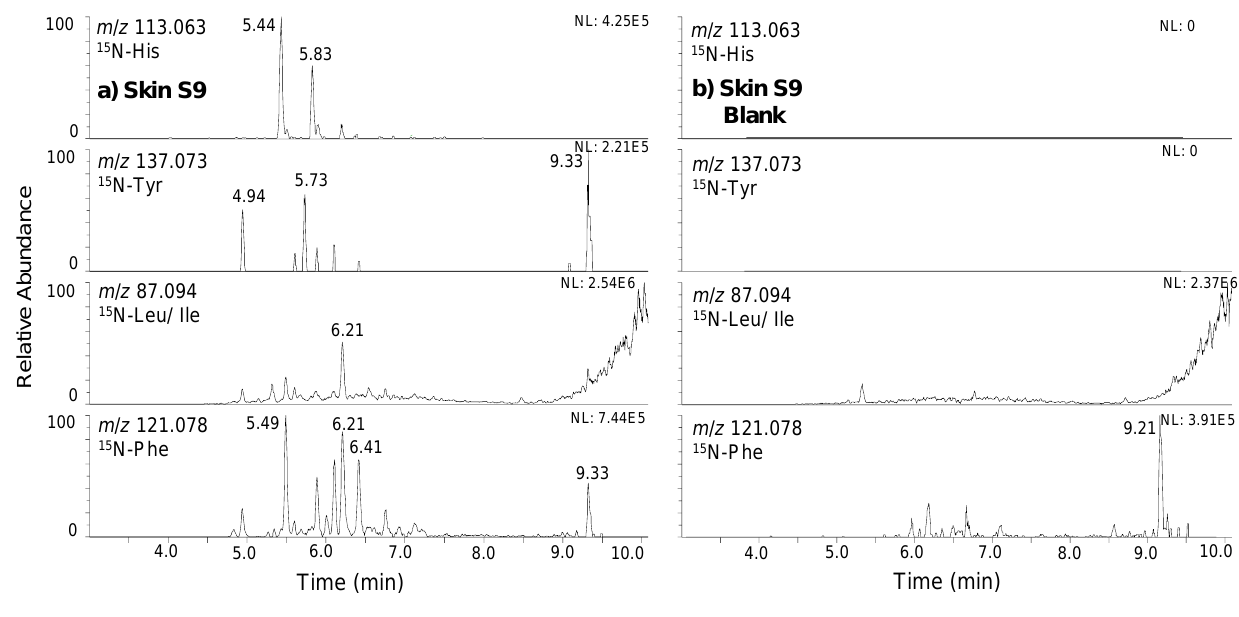
Figure 3. AIF chromatogram of the extracted ion traces corresponding to the most abundant 15 N- labelled immonium ions, showing the metabolites obtained after incubation of 15 N-hGH in skin S9 mix ( a )) in comparison to the respective substrate blank ( b )). Table 1. Amino acid sequences and main characteristics of the metabolites derived from hGH using the presented IRIS approach. The most promising fragments for doping control analysis are highlighted in bold. (+ indicates the detection) .